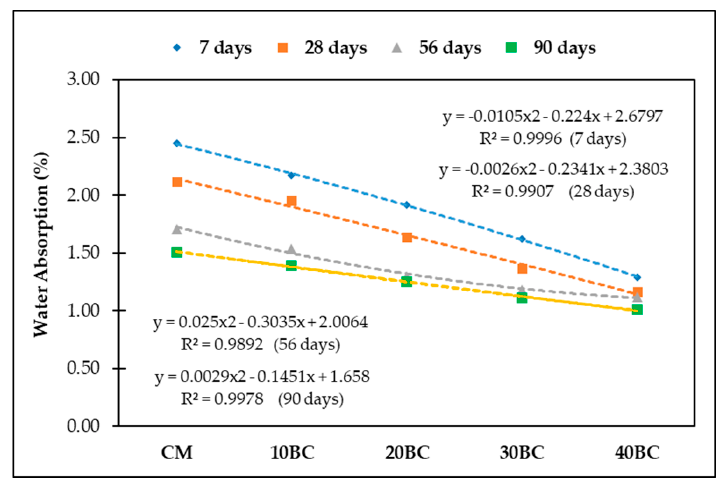
Figure 8. Regression equations for water absorption for different concrete mixes.